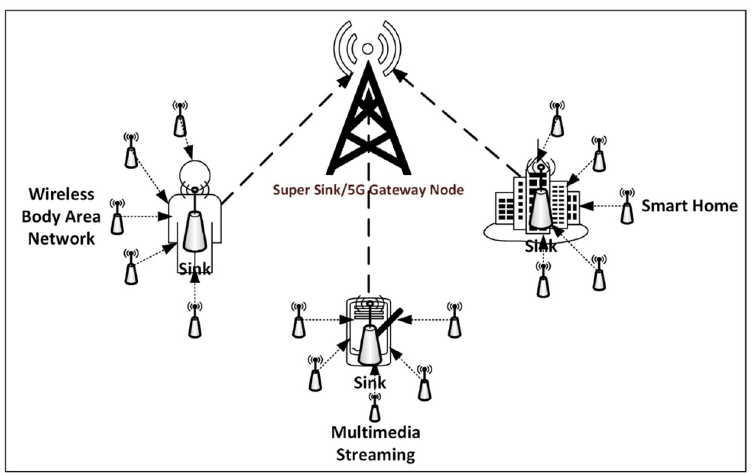
Fig 1. RPL routing architecture and applications of